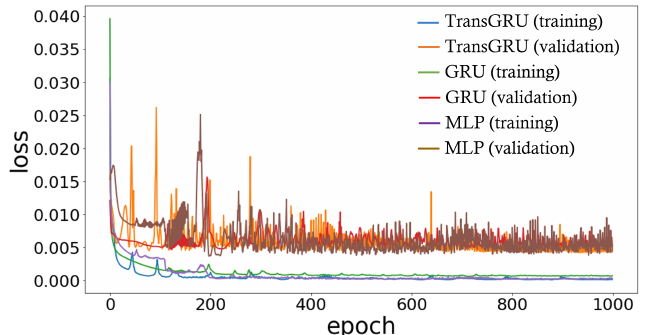
Figure 7. Learning curve comparison during training and